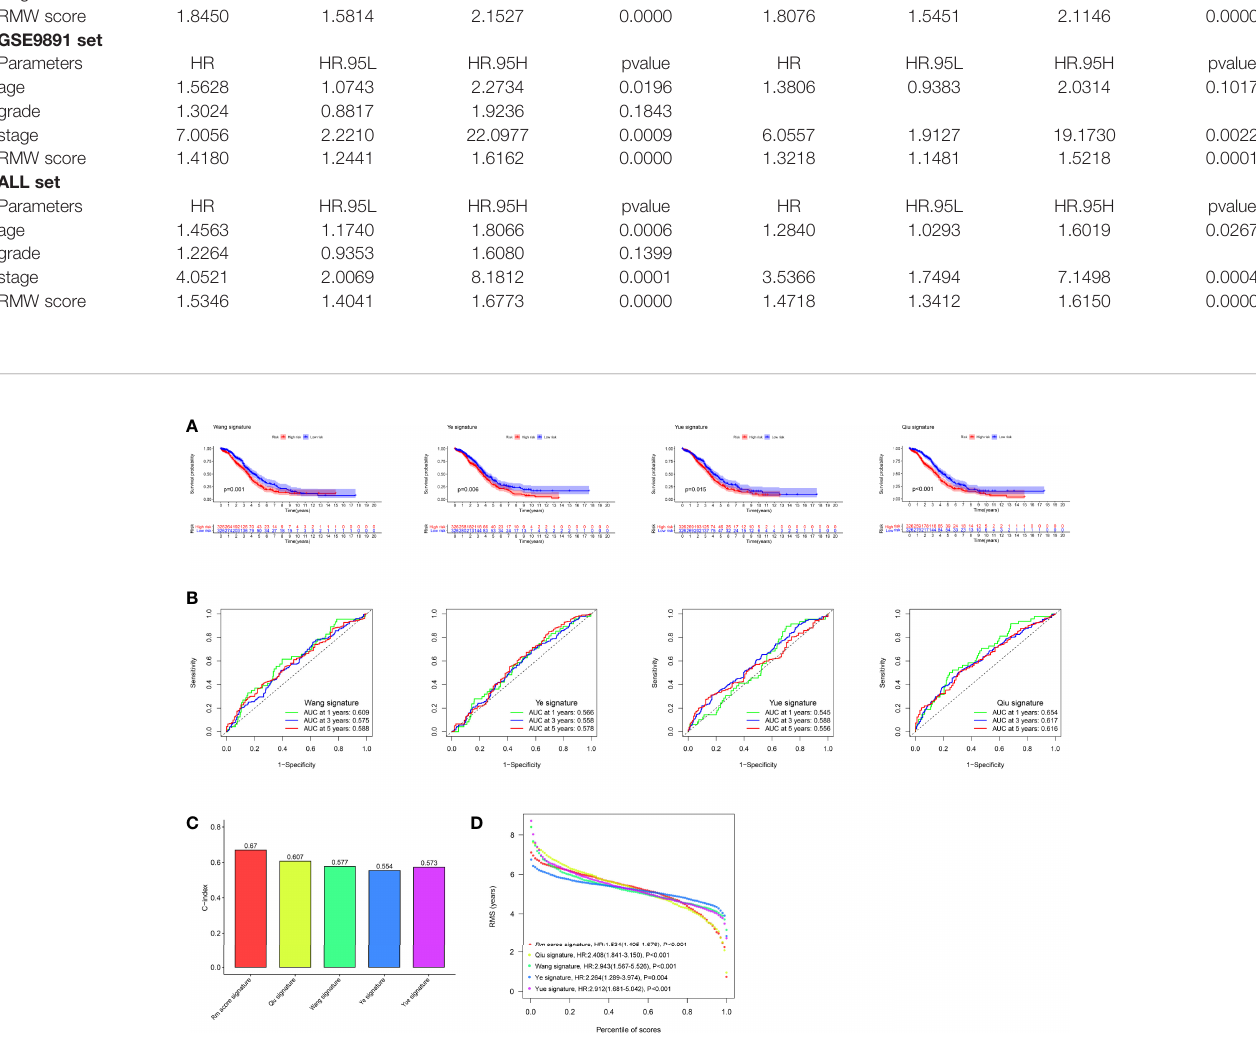
FIGURE 9 | Comparison of our risk model with other established models. (A) Kaplan – Meier (K-M) curves of four other published gene signatures. (B) Receiver operating characteristic (ROC) curves of four other published gene signatures. (C) Concordance index (C-index) of the fi ve prognostic risk models. (D) Restricted mean survival (RMS) time curve of all fi ve prognostic risk